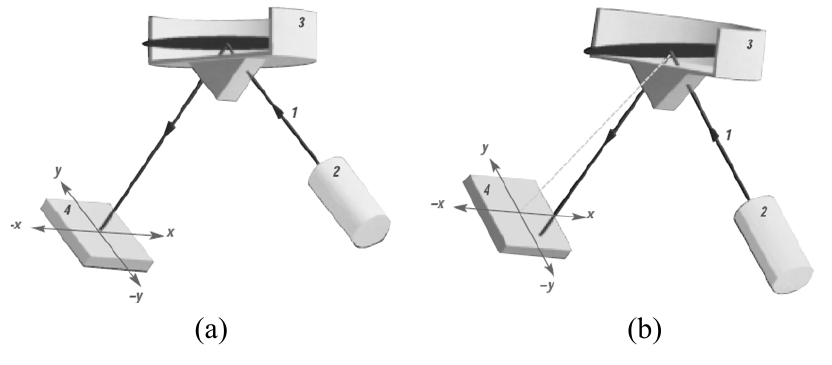
Figure 1. Functional principles of the inclinometer: (a) Horizontal position. (b) Tilted position. 1 The light from the LED, 2 LED, 3 Container with liquid inside, 4 Biaxial position detector